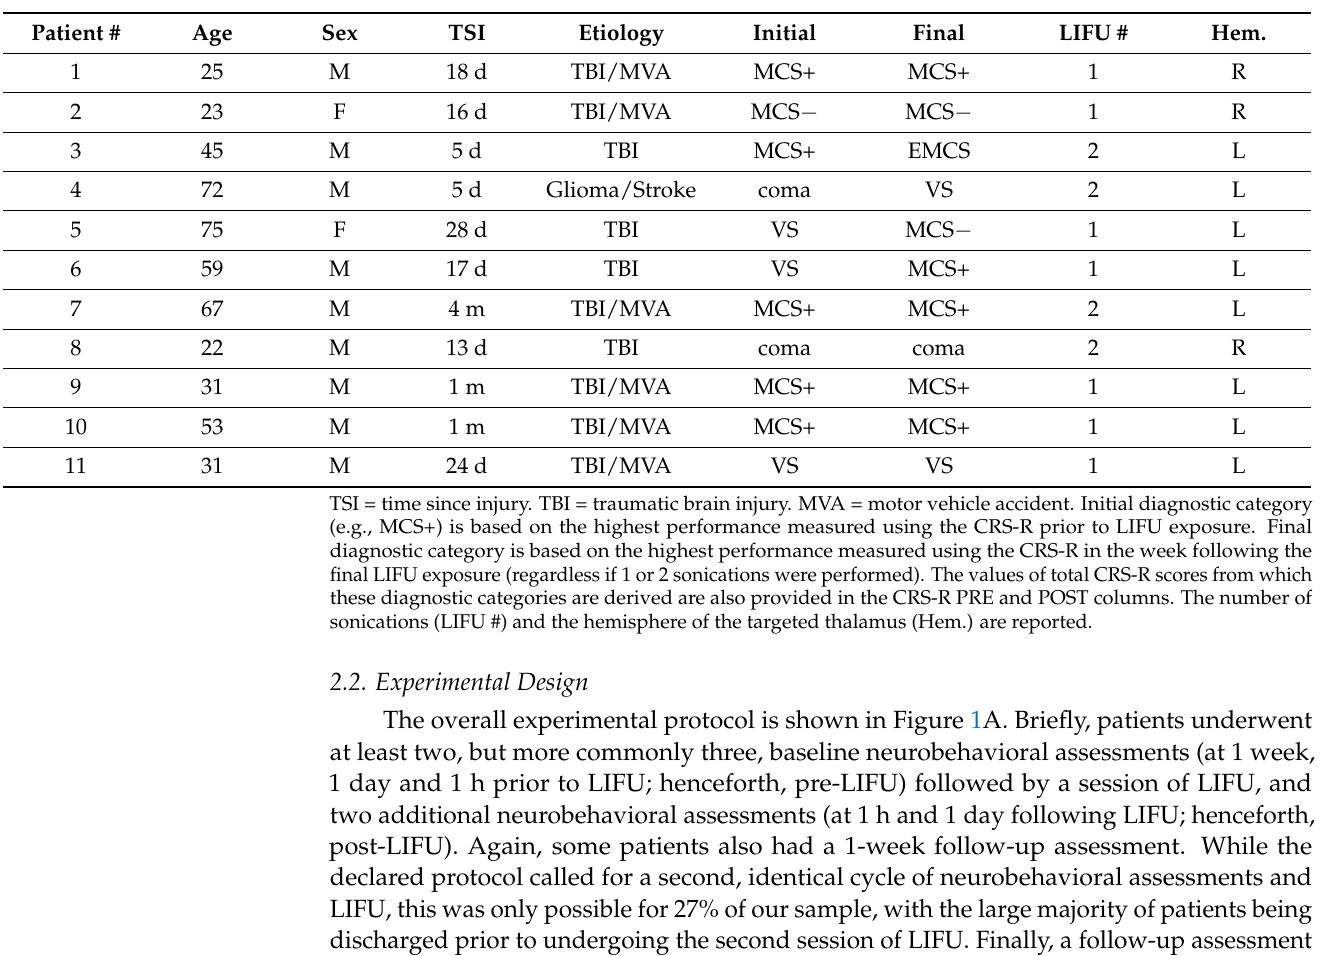
Table 1. Relevant patient-specific